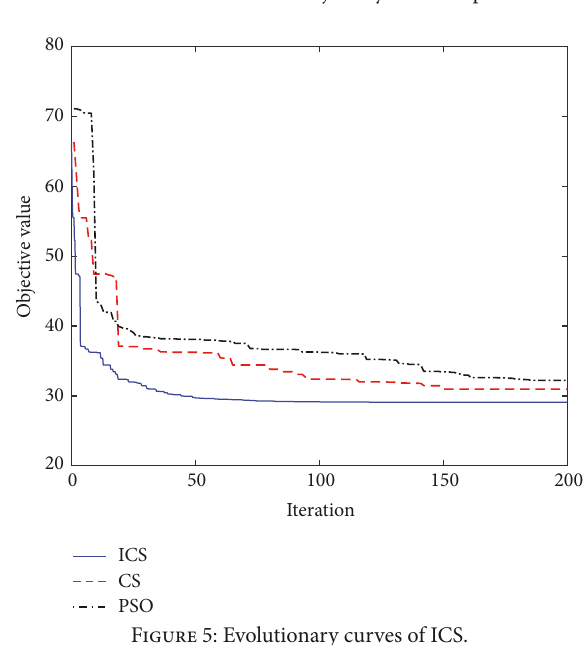
Figure 5: Evolutionary curves of ICS.